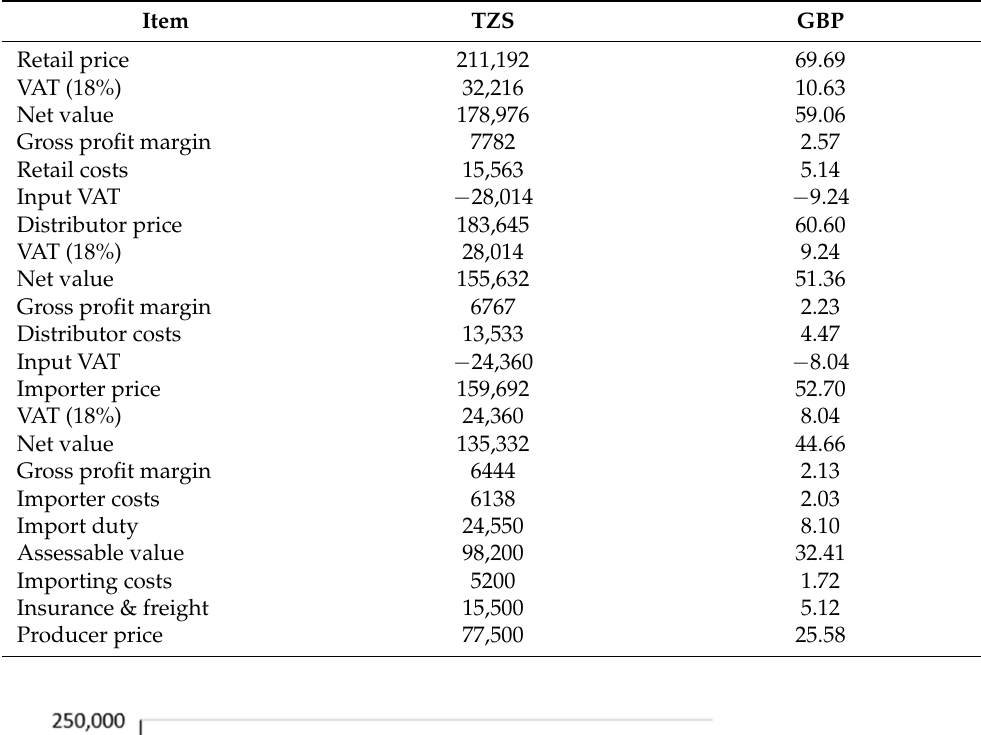
Table 5. Gross margin and pricing structure analysis for EPCs.